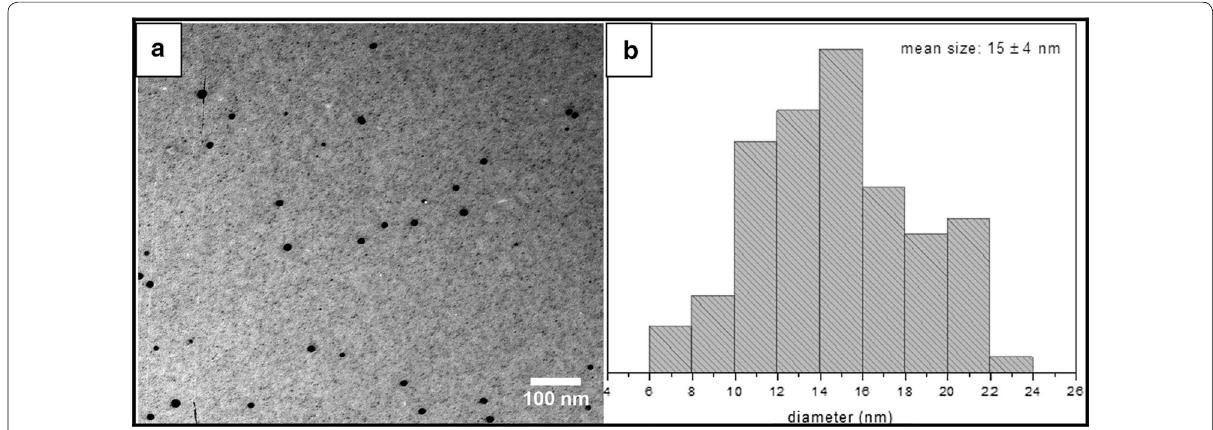
Fig. 1 a Silver nanoparticles (AgNP) image acquired by transmission electron microscopy (TEM). b Size distribution calculated from several TEM